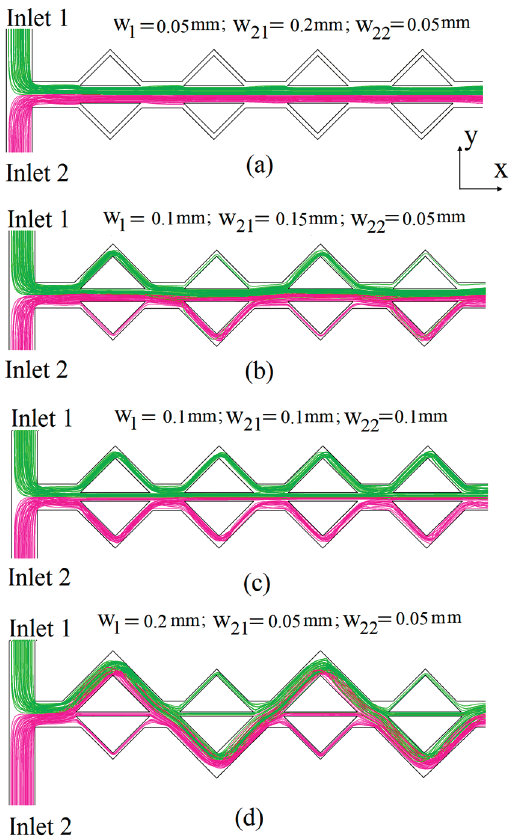
Figure 13. Projected streamlines starting from Inlet 1 and Inlet 2 at middle height of the channel and Re = 40 for the three-split micromixer for various minor sub-channel widths.